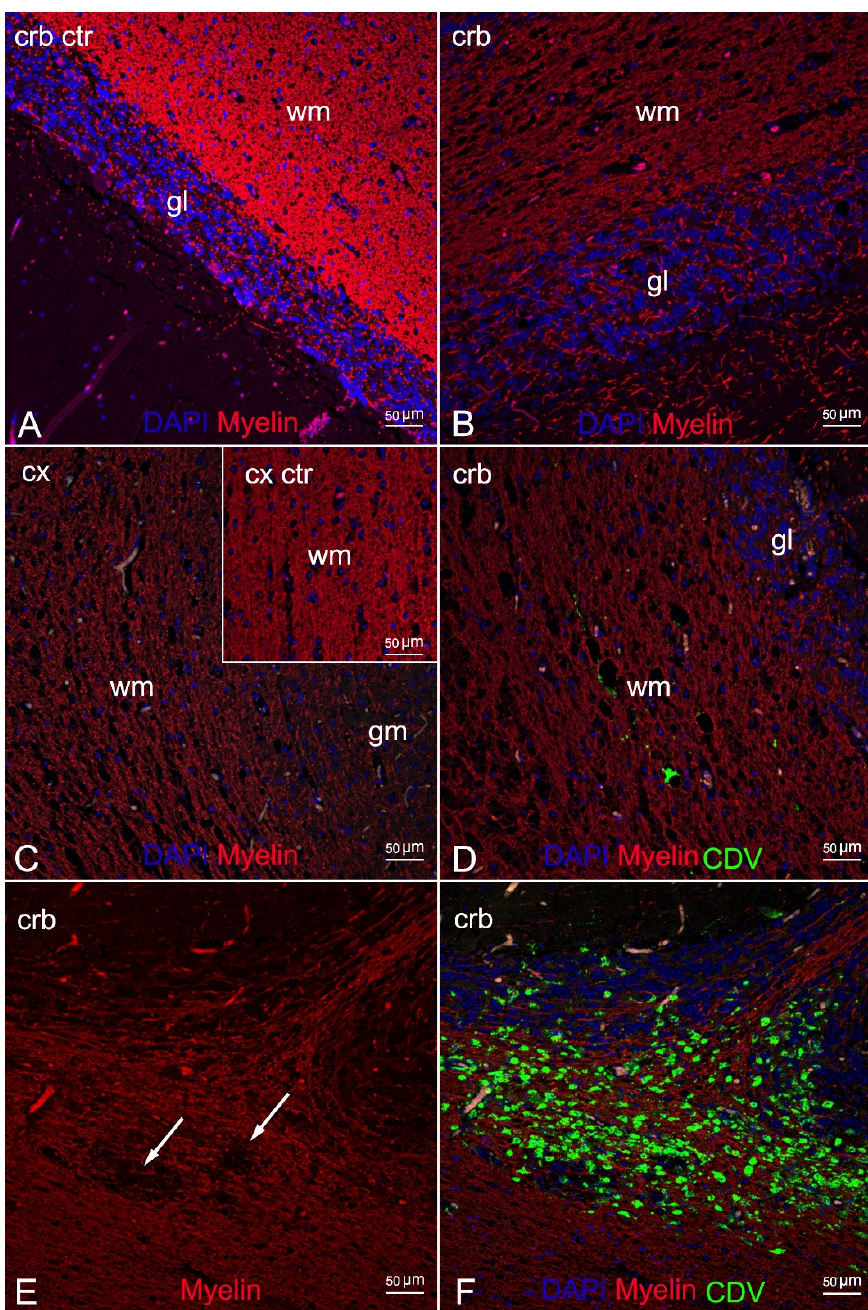
Figure 4. Morphological characterization of myelinopathy by means of double IF for myelin and DMV. ( A ) Cerebellar cortex (negative control). Myelinated white matter. ( B ) Cerebellar cortex (ID 28). Marked reduction in the myelin density with partial loss of tissue organization. ( C ) Cerebral cortex (ID 9). Severe reduction of myelin density, 20x. Inset: cortical cortex (negative control). Myelinated white matter. ( D ) Cerebellar cortex (ID 28). Limited DMV infection of the demyelinated white matter. ( E ) Cerebellar cortex (ID 10). Demyelinated white matter with complete loss of myelin (arrows). ( F ) Cerebellar cortex (ID 10). Severe DMV infection of the demyelinated white matter and the granular layer. Legend: wm, white matter; gm, grey matter; gl, granular layer; Cx, cortex; Crb, cerebellum; Ctr, negative control; DAPI, 4,6-diamidino-2-phenylindole; DMV, dolphin morbillivirus; CDV, canine distemper virus. Comparison of double staining between the anti-GFAP and the anti-CDV abs showed marked astrocytosis, with reactive astrocytes inside and around the demyelinated